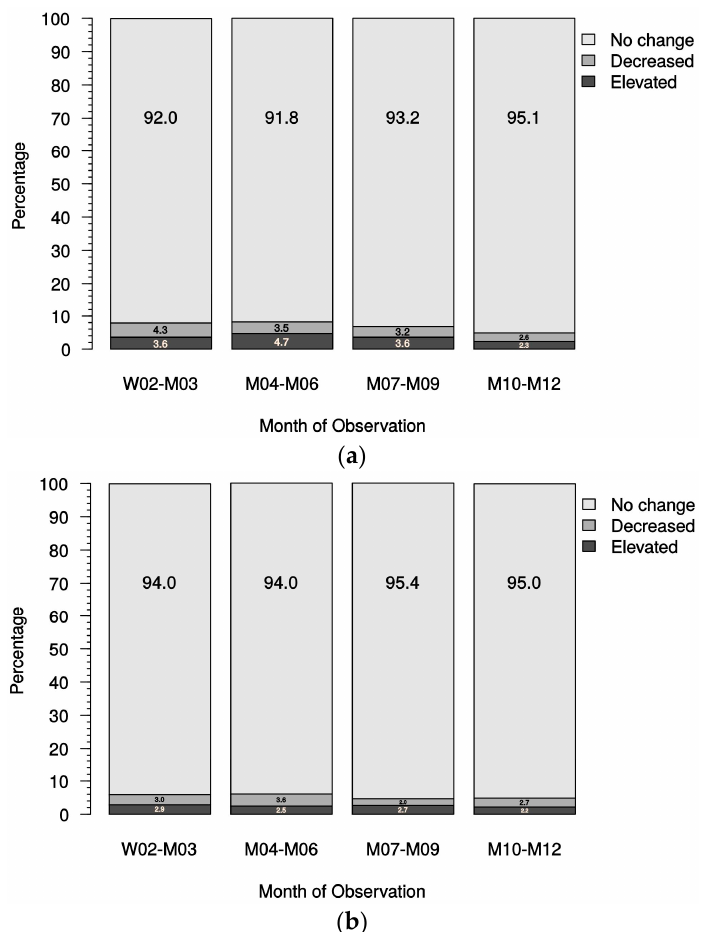
Figure 3. ( a ) Cumulated dose change in patients receiving oral paricalcitol; ( b ) cumulated dose change in patients receiving IV paricalcitol. M, month; W, week.